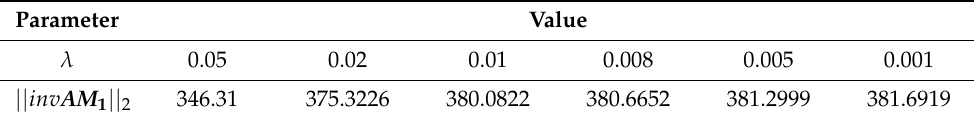
Table 2. Values of || inv AM 1 || 2